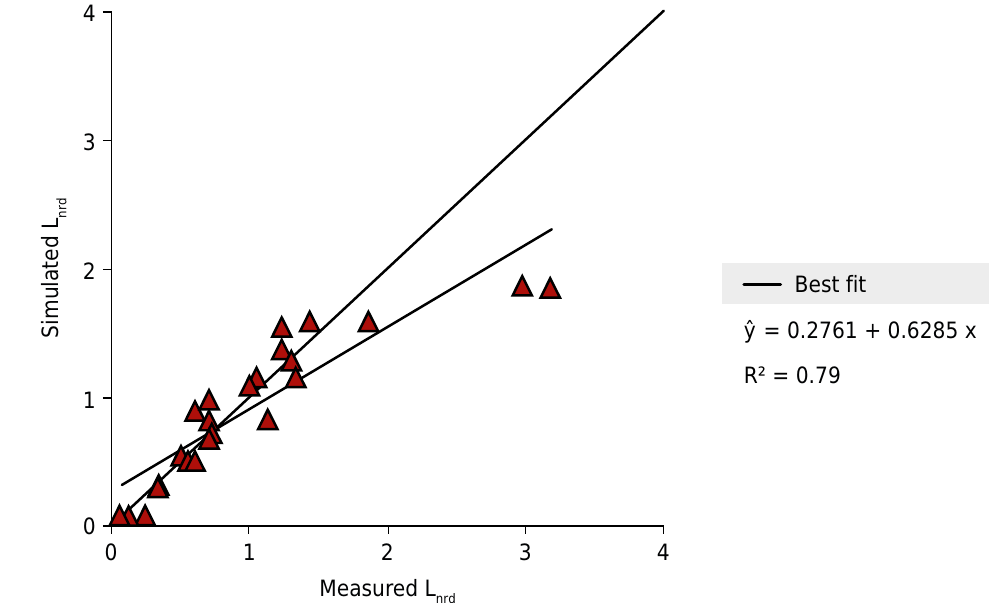
Figure 5. Overall comparison of normalized root length density distribution between measurement and simulation.